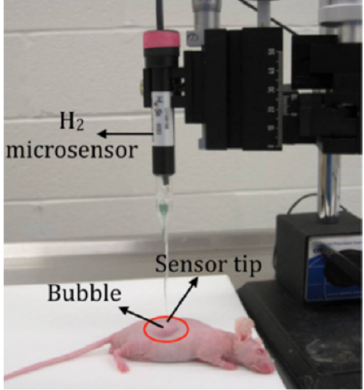
Figure 8. Hydrogen microsensor with direct contact between sensor tip and mice; used to detect and measure hydrogen evolving from an allow of Mg implanted in the mice [34].